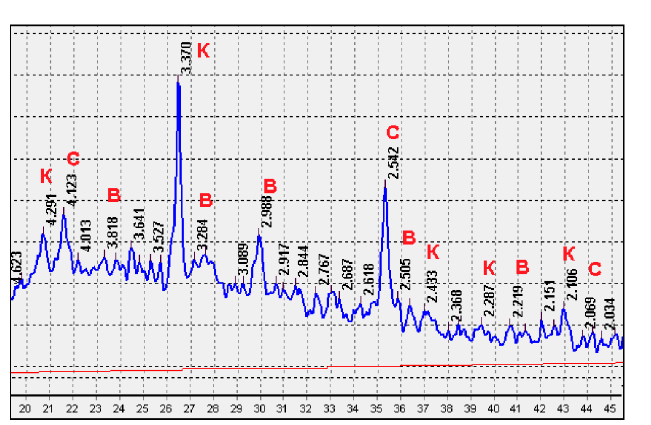
Figure 9. The microstructure of the liquid glass binder (mixture 39), fired at 350 °C. The fired liquid glass mass consists of crystalline and X-ray amorphous phases (Fig- ure 10). The presence of crystalline phases of β -quartz, α -crystobalite and wollastonite is mainly due to the participation of fly ash in the processes of structure formation of the binder paste. An increase in the crystalline component in the binder with an increase in the paste (Figure 11, Table 8).